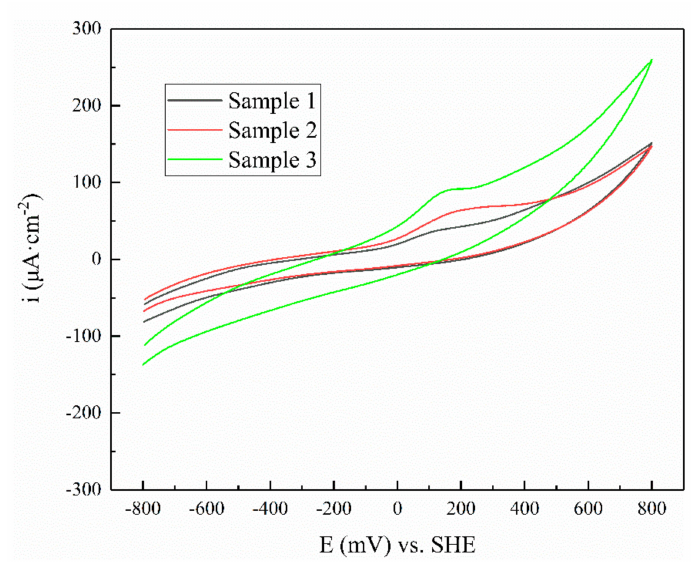
Figure 10. Cyclic voltammogram curves of the three samples in a solution with a xanthate concentration of 1.8 × 10 − 4 mol / L at scan rate of 20 mV /